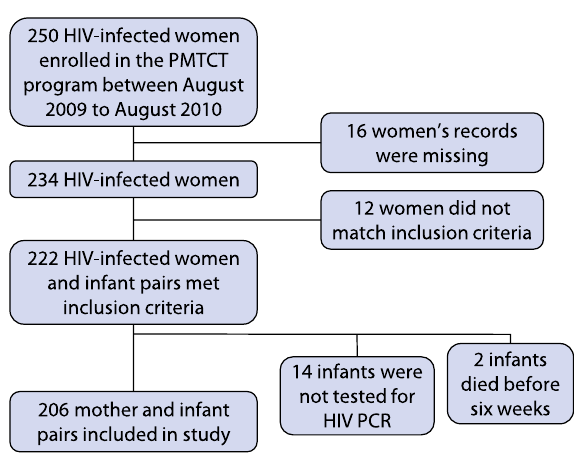
Figure 1: Process of record selection.